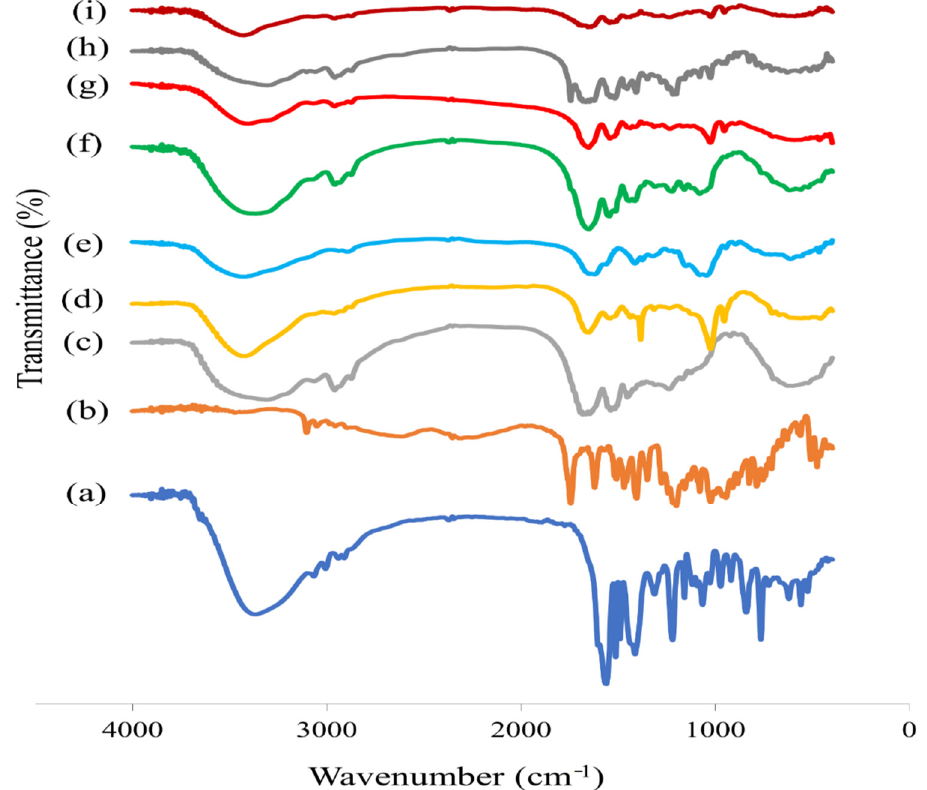
Figure 5. The IR charts of ( a ) pitavastatin, ( b ) tedizolid, ( c ) zein, ( d ) BGT 5 , ( e ) sodium hyaluronate, ( f ) physical mixture of D-ZIFI 1, ( g ) the implant of D-ZIFI 1, ( h ) physical mixture of D-ZIFI 2, and ( i ) implant of D-ZIFI 2.